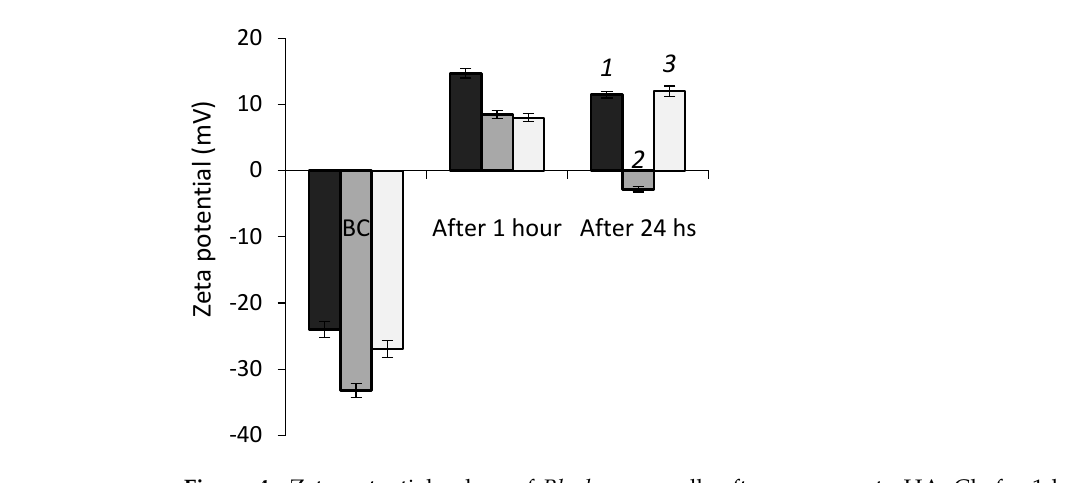
Figure 4. Zeta potential values of Rhodococcus cells after exposure to HAuCl 4 for 1 h and 24 h. BC—biotic control. (1)— R. erythropolis IEGM 766, (2)— R. ruber IEGM 1135, and (3)— R. fascians IEGM 525.